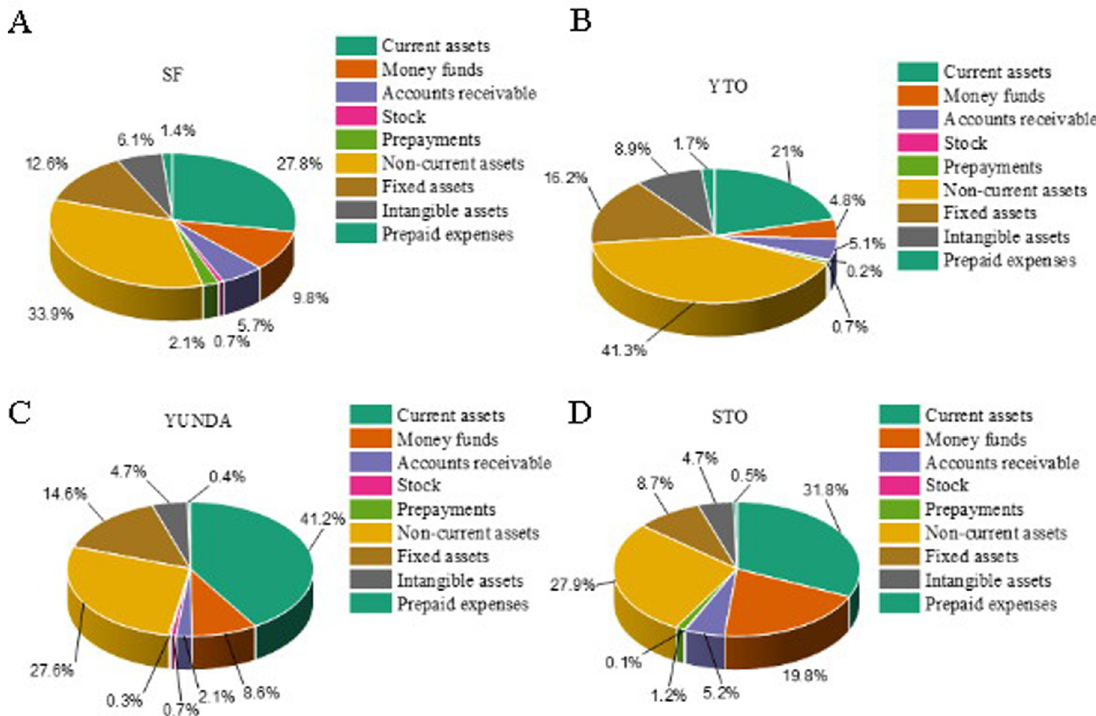
Fig 3. Asset structures of different express